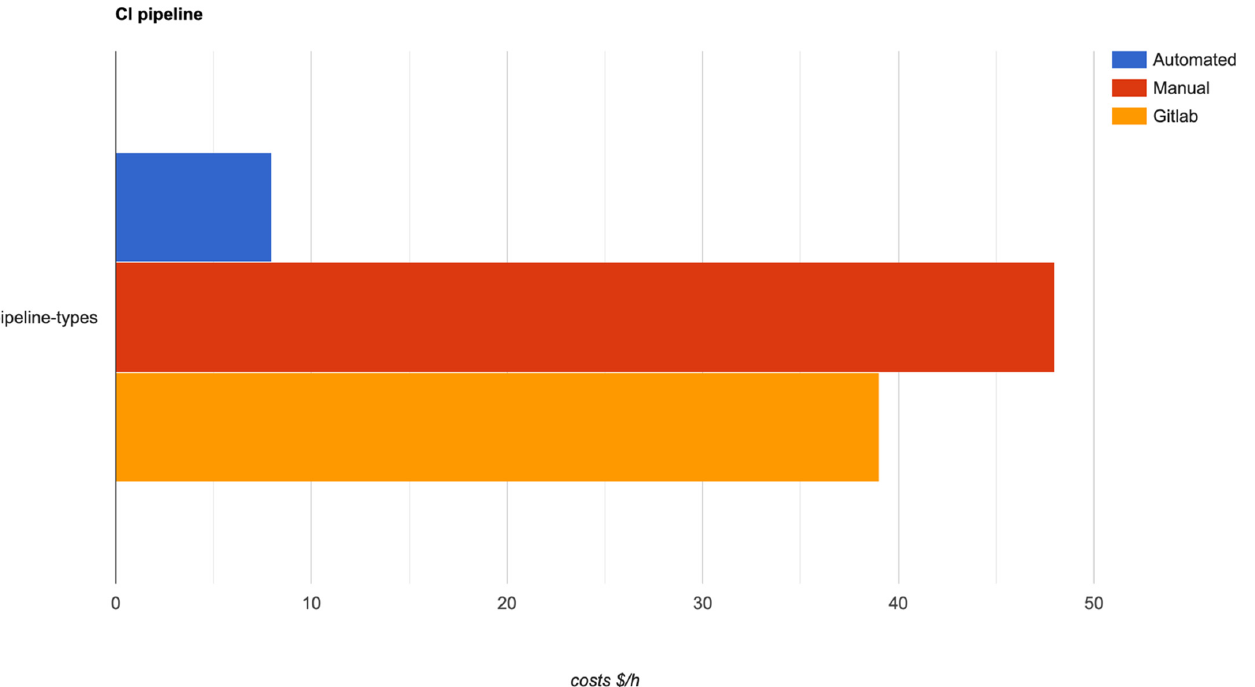
Figure 15. RabbitMQ deployed with the proposed solution.